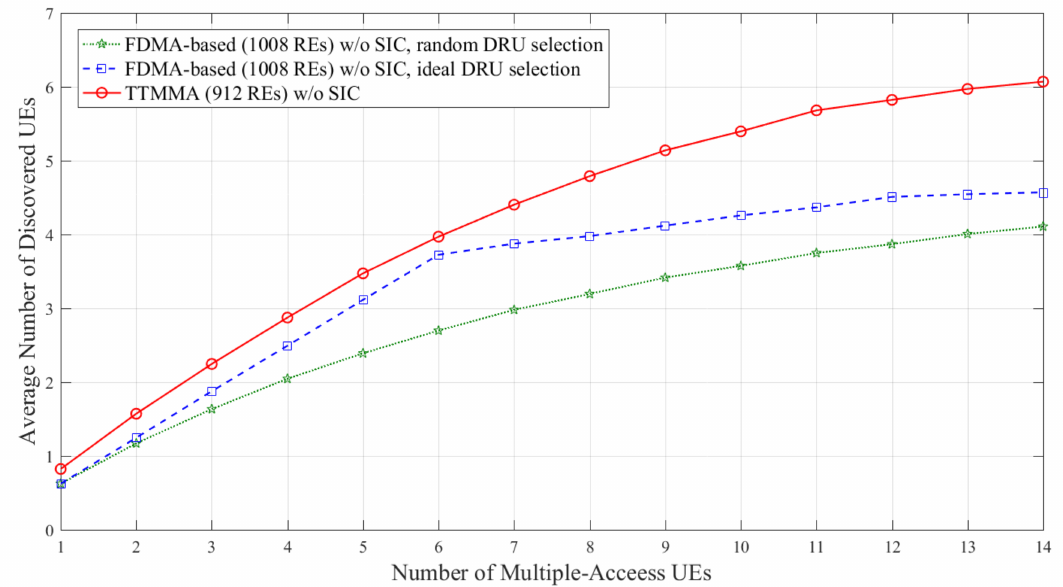
Figure 7. Average number of discovered user equipment (UEs) according to the number of multiple-access UEs in block Rayleigh fading channel without applying successive interface cancellation